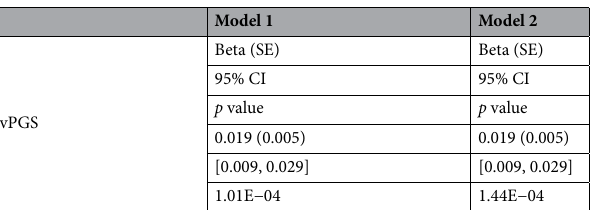
Table 2. Variance polygenic score (vPGS) validation in the UK Biobank. Abbreviations: SE, standard error; CI, confidence interval. Results show the association between the vPGS and the between-individual variance in BMI in a 20% holdout sample of the UK Biobank. Model 2 adjusts for the effect of the mean PGS (mPGS). Unique N =